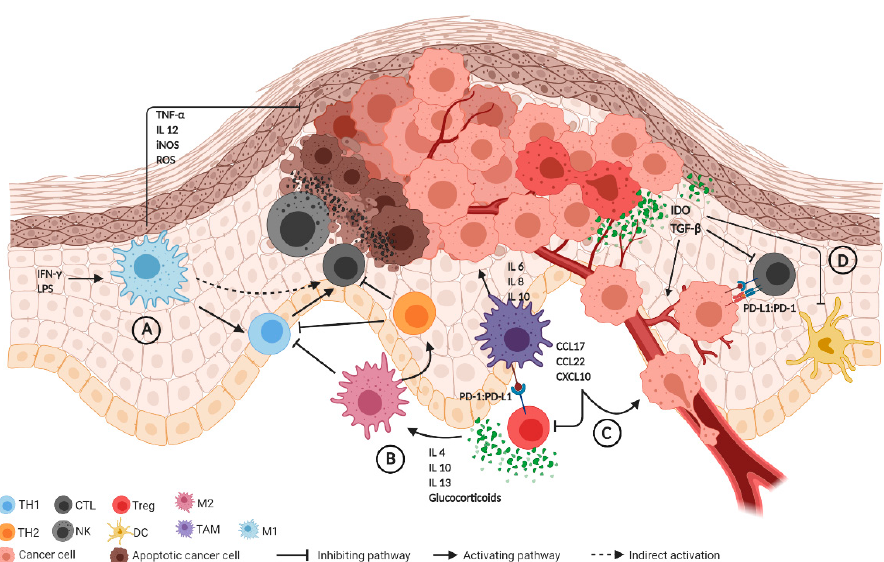
Figure 1. Summary of the immune tumor microenvironment (TME). ( A ) Immune stimuli (e.g., IFN- γ , LPS) activate M1 macrophages that release anti-tumoral agents including TNF- α , IL-12, iNOS and ROS, also promoting the TH1 response. ( B ) Glucocorticoids and IL-4, IL-10, IL-13 stimulate M2 macrophages, which inhibit TH1 and enhance the TH2 response, with subsequent CTL suppression. TH2 activation further inhibits the TH1 response. ( C ) TAMs express PD-L1, CCL17, CCL22 and CXCL10, exerting an immunosuppressive effect through Treg and promoting tumor growth. TAMs are also involved in cancer progression through the release of IL-6, IL-8 and IL-10. ( D ) The release of IDO and TGF-beta by cancer cells inhibits alloreactive lymphocytes. PD-L1 expression by cancer cells also suppresses CTL activity. Abbreviations: CCL17, CCL22: C-C motif chemokine ligand 17 and 22; CTL: cytotoxic T cells; CXCL10: C-X-C motif chemokine ligand 10; DC: dendritic cell; IDO: indoleamine 2,3-dioxygenase; IL 4, 6, 8, 10, 12, 13: interleukin; iNOS: inducible nitric oxygen synthase; LPS: lipopolysaccharide; NK: natural killer; PD-1: programmed death 1; PD-L1: programmed death-ligand 1; ROS: reactive oxygen species; TAM: tumor-associated macrophage; TH1, TH2: T helper 1 and 2; TNF- α : tumor necrosis factor α ; TGF- β : transforming growth factor- β ; Treg: T regulatory cell.